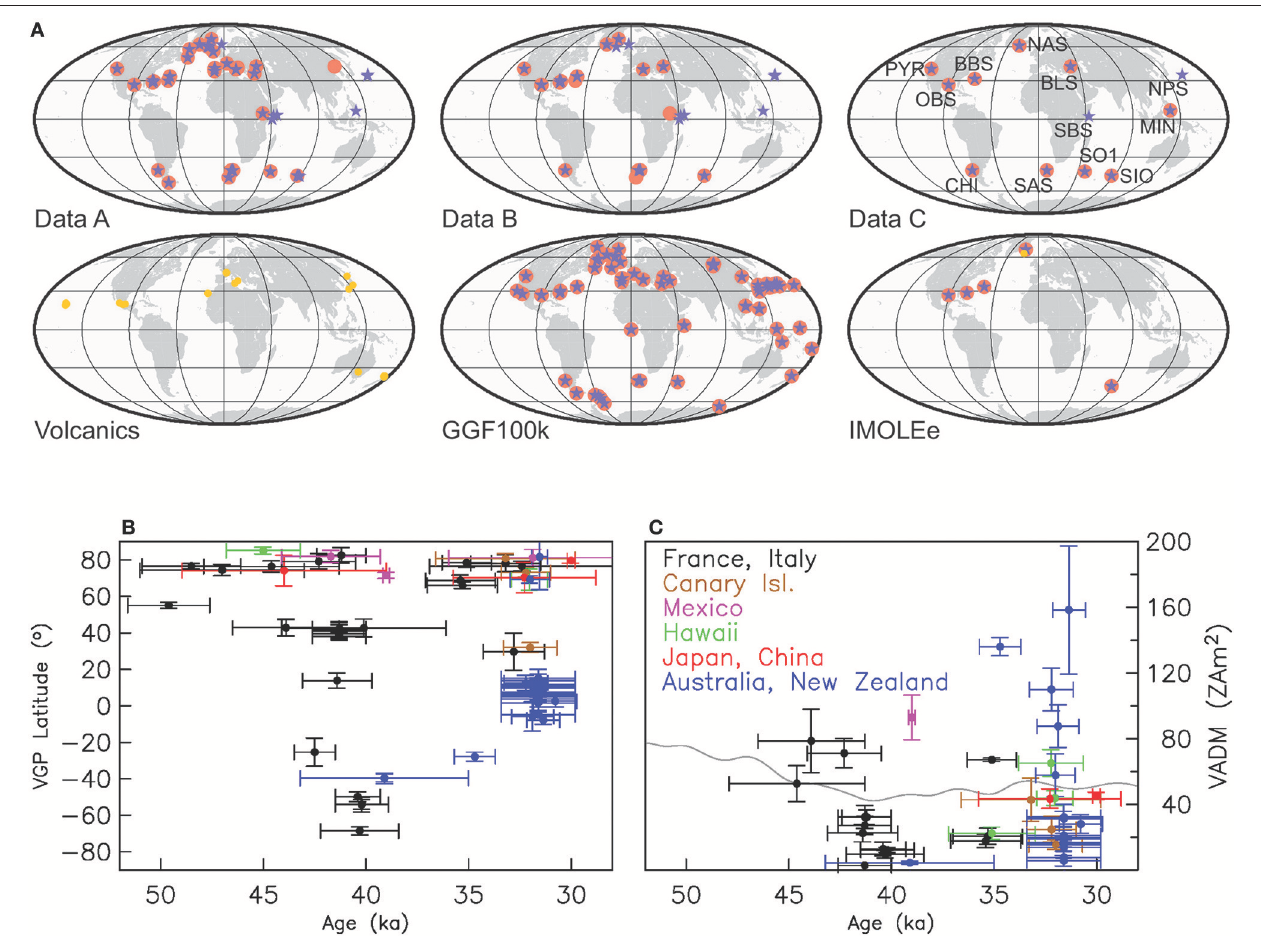
FIGURE 1 | Spatial data distribution for the models investigated in this study (A) . Red dots indicate locations with directional and blue stars with intensity data, for the different models. Orange dots (bottom left) indicate the locations of volcanic data. Their distribution for GGF100k is very similar, whereas IMOLEe (bottom right) includes only one volcanic record from Iceland indicated in that panel by an orange dot. Volcanic data are unevenly distributed in time, both for directions (B) and intensity (C) . Volcanic results from one region hardly cover the full time interval. The gray line intensity time series in (C) is the axial dipole moment reconstruction PADM2M ( Ziegler et al., 2011) used for our sediment RPI